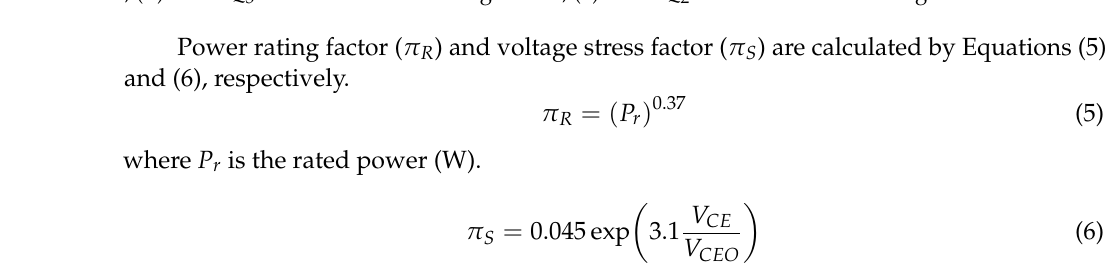
Figure 6. Sub fault-tree: ( a ) IGBT Q 1 reverse current flowing failure; ( b ) Capacitor charging function failure; ( c ) Capacitor discharging function failure; ( d ) IGBT Q 3 reverse current flowing failure; ( e ) IGBT Q 2 reverse current flowing